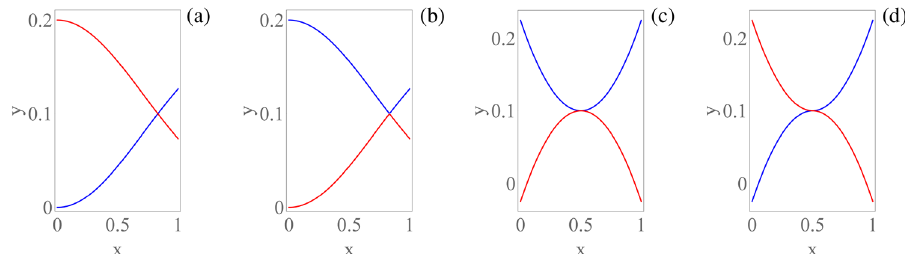
Figure 5. Two curves intersecting at one point, with different slopes: ( a ) curve labeling preserving differentiability at the intersection; ( b ) curve labeling not preserving differentiability at the intersection, and associated with a higher objective value in Eq. (6) than the labeling in part ( a ) of the figure. Two curves intersecting at one point, with the same slope: ( c ) curve labeling preserving differentiability at the intersection; ( d ) nonequivalent curve labeling preserving differentiability at the intersection, and having the same objective value in Eq. (6) as the curve labeling in part ( c ) of the